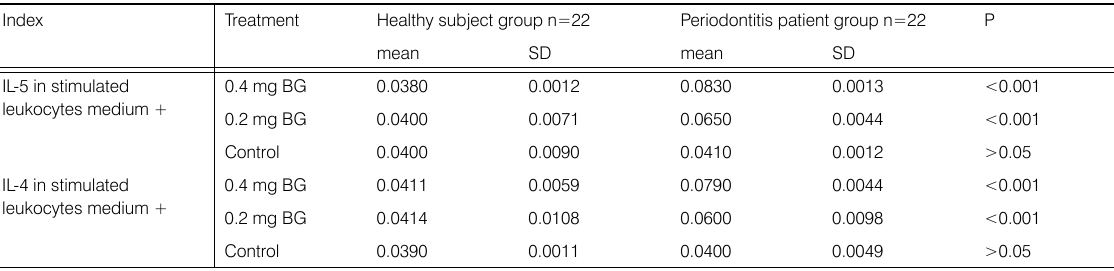
Table 6. IL-5 and IL-4 levels in leukocyte medium stimulated by unopsonized E. coli and treated with ß